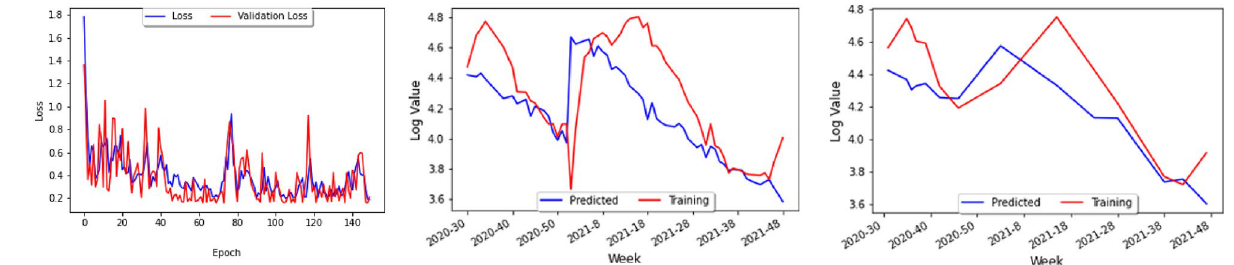
Figure 25. (Left) Loss curve, (Center) Training predictions, (right) Test